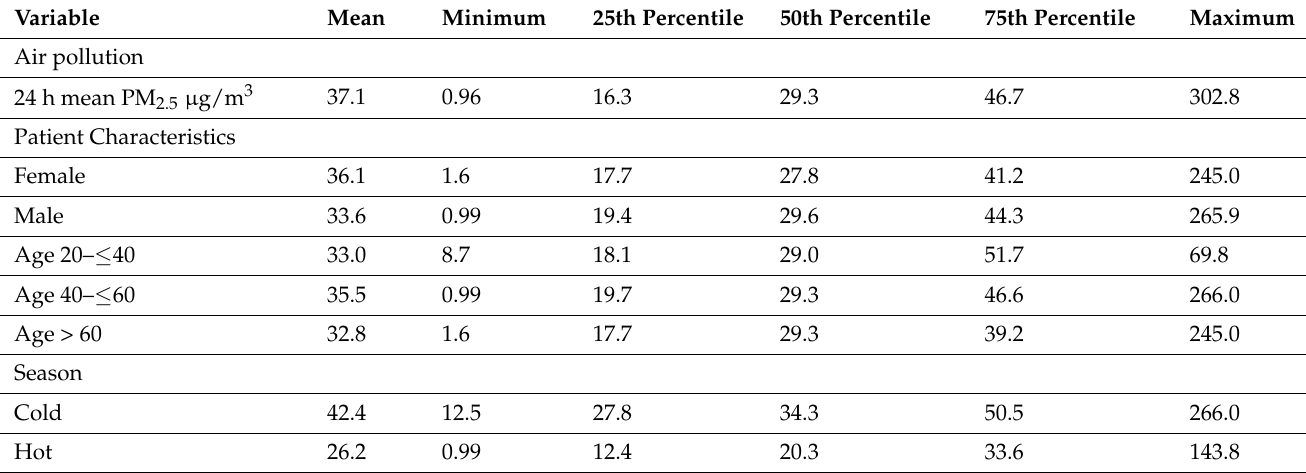
Table 2. Air pollution statistics for PM 2.5 in relation to patient demographic and season characteristics.